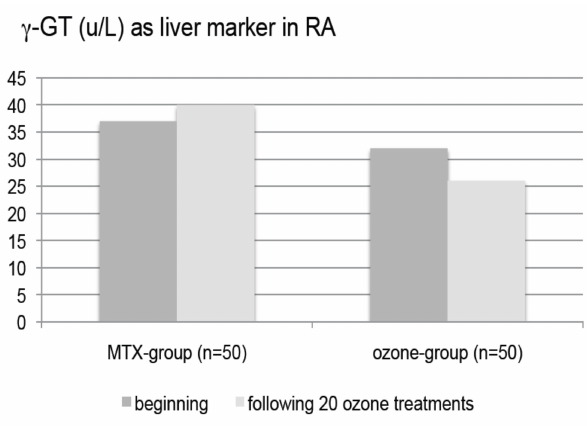
Figure 11. Liver toxicity of standard antirheumatic drugs is reduced by low-dose ozone, here shown as γ -GT ( γ -glutamyl transferase) in a clinical trial with 100 Rheumatoid arthritis patients. MTX-group ( n = 50): Metotrexate + Ibuprophen + Folic acid. Ozone-group ( n = 50): MTX group + ozone. 20 rectal ozone insufflations 200 mL, concentrations 25–40 µ g/mL during 4 weeks